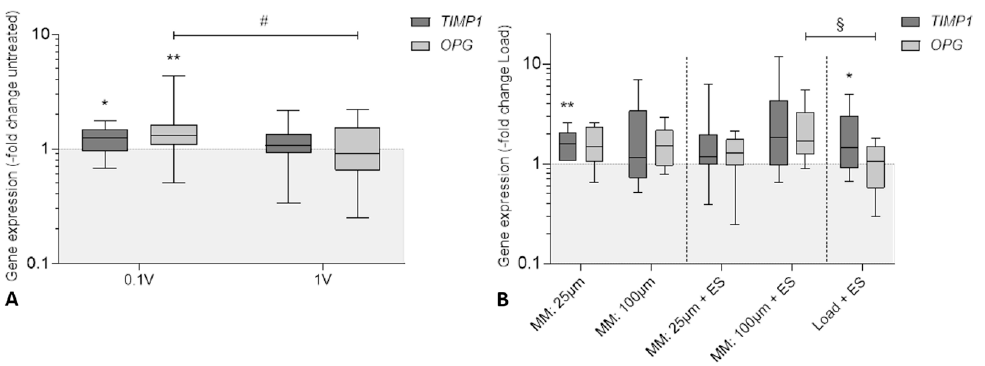
Figure 6. Relative gene expression of genes responsible for bone remodeling: tissue inhibitor